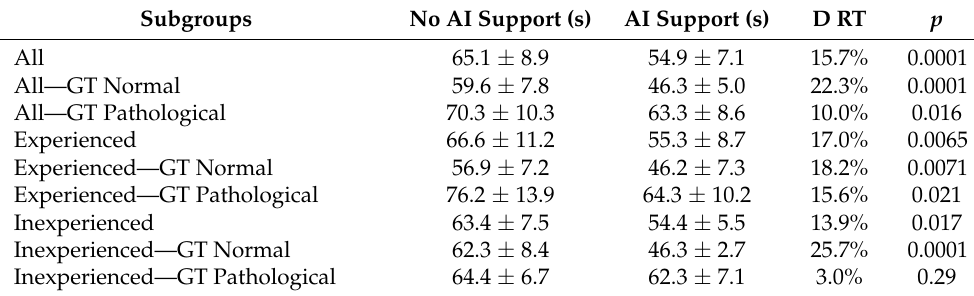
Table 2. Reporting times (mean ± standard deviation) in seconds for experienced/inexperienced readers, as well as subgroups according to experience levels and ground truths. GT: ground truth, RT: reporting